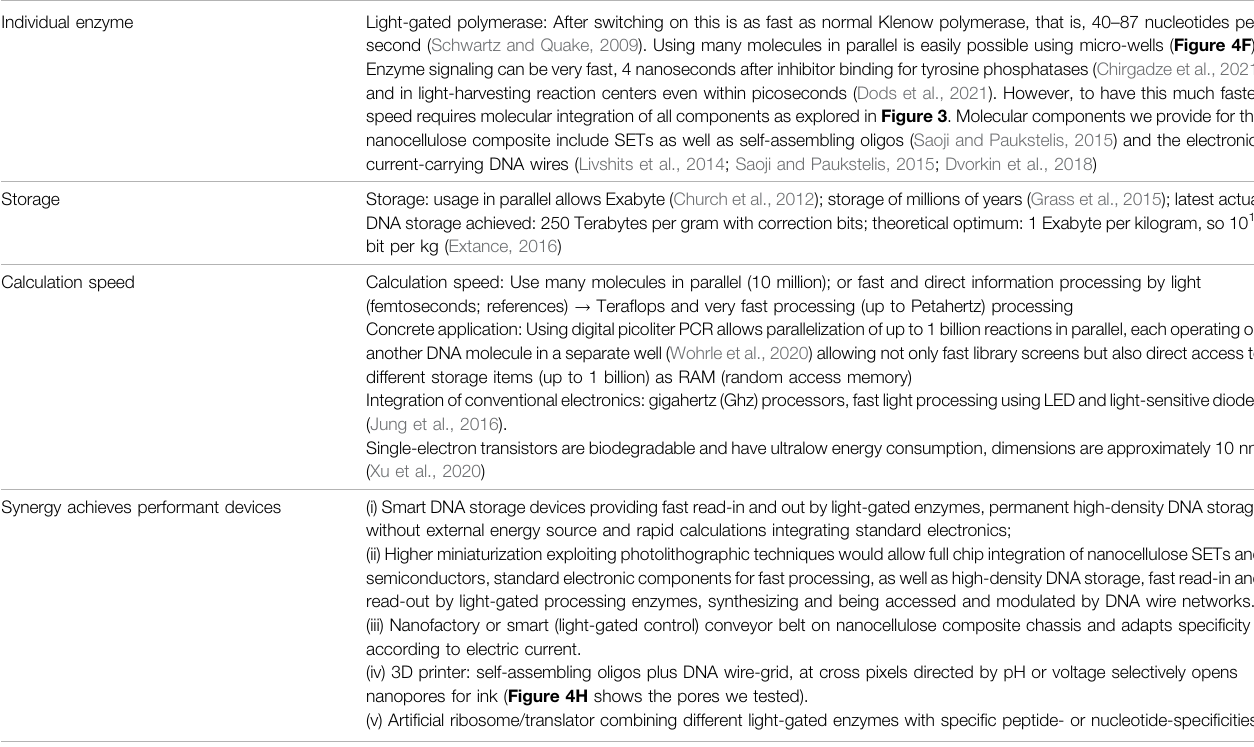
TABLE 4 | Optimal performance characteristics. Individual